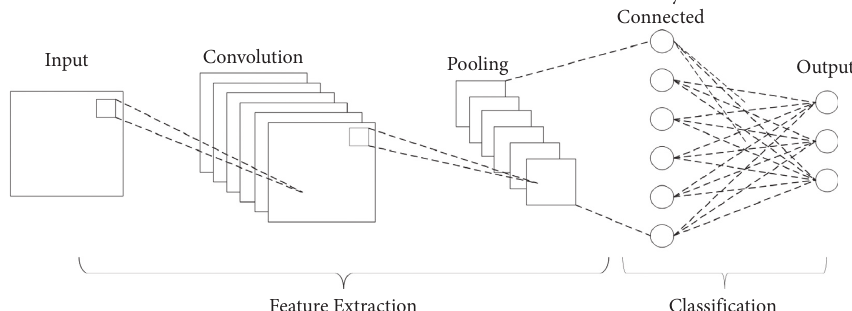
Figure 1: Illustration of the feature extraction process from image data to produce the final classification with a basic CNN architecture. The figure is recreated from [17].